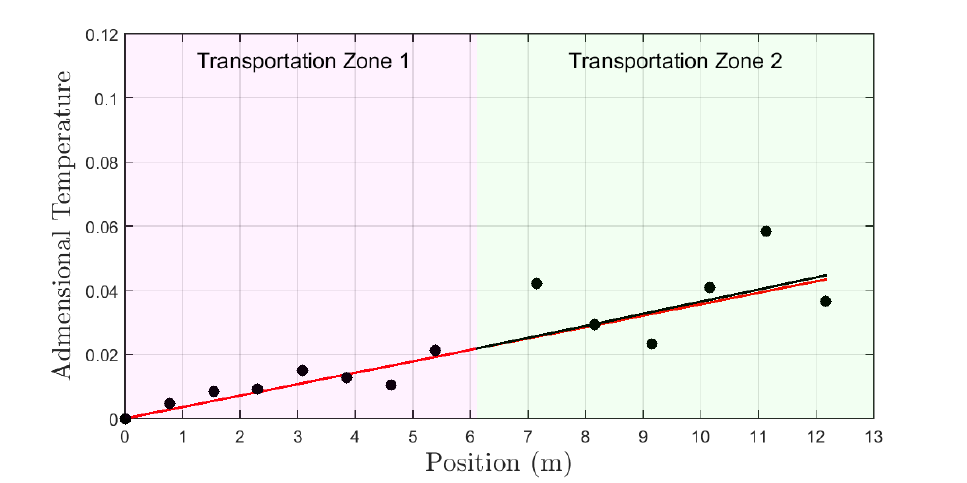
Figure 12. Dimensionless profile—experiment type A.